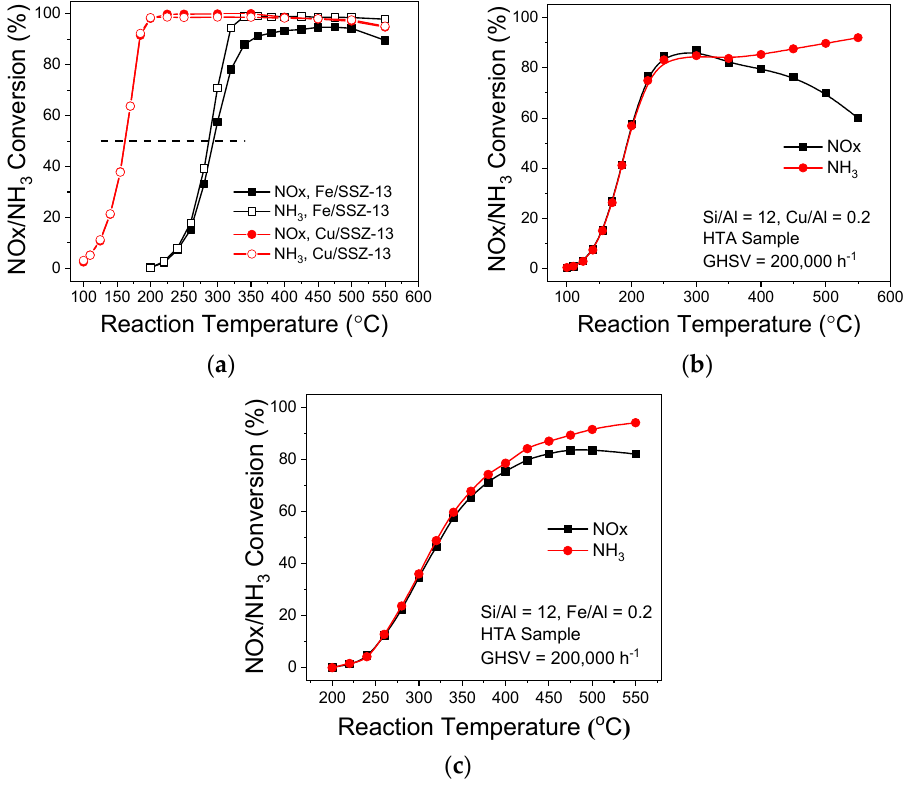
Figure 15. NOx / NH 3 conversions as a function of temperature during standard SCR for the ( a ) fresh Cu- and Fe / SSZ-13 samples, ( b ) hydrothermally aged Cu / SSZ-13, and ( c ) hydrothermally aged Fe / SSZ-13. Reactant feed contains 350 ppm NO, 350 ppm NH 3 , 14% O 2 , 2.5% H 2 O balanced with N 2 at a GHSV of 200,000 h − 1 . Reprinted with permission from [33]. Copyright © 2015 Elsevier B.V.